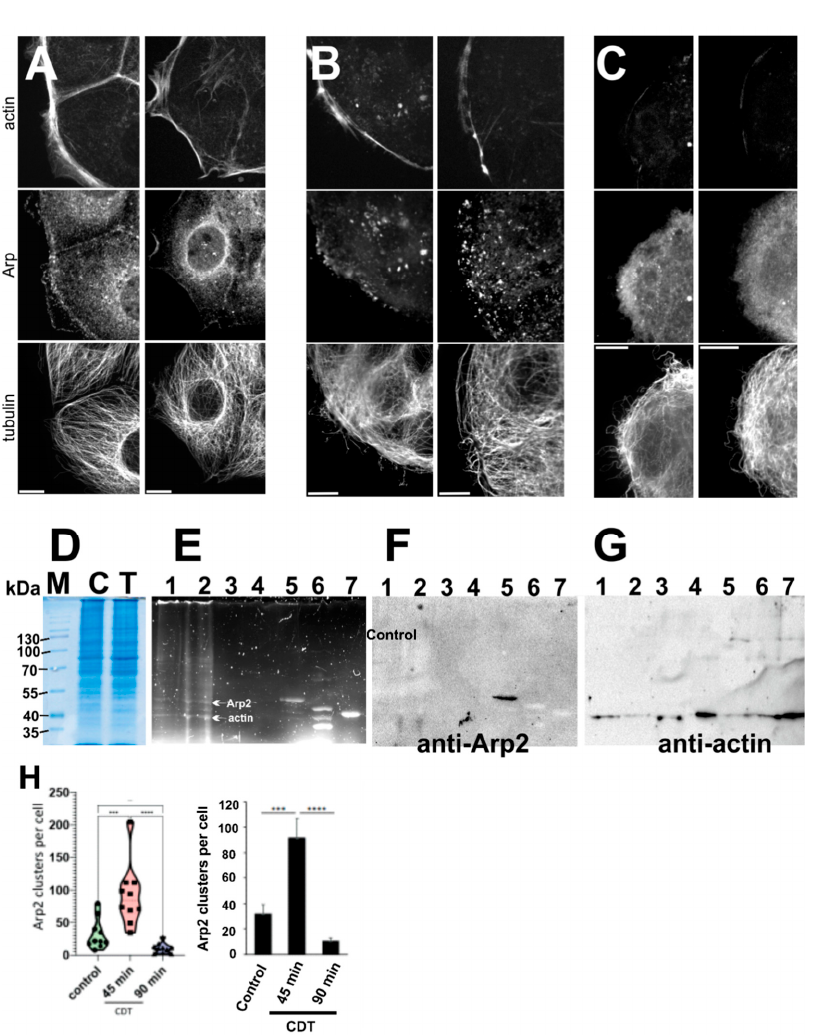
Figure 5. Effect of CDTa on Caco2 cells. ( A – C ) Caco2 cells seeded n coverslips were exposed to the CTDa and CDTb components to allow intracellular transport of CDTa by the membrane insertion CDTb component. ( A ) Control before intoxication, ( B ) 45 min and ( C ) 90 min after intoxication. After the indicated incubation periods, the cells were fixed and stained with TRITC-phalloidin (top rows). Anti-Arp2 mAb (middle rows); and anti-tubulin (lower rows) (for details see text). Bars correspond 10 µm. ( D – G ) Caco2 cells were incubated with CDTa and CDTb components, 0.1 mM etheno-NAD and 0.15 mM TritonX-100 to allow etheno-NAD diffusion into the cells. After 2 h or 3 h the cells were collected, washed 5 times in PBS and finally taken up in RIPA buffer to solubilize the cell content. After centrifugation the supernatants of the cell homogenates were analyzed by SDS-PAGE (12.5% polyacrylamide): ( D ) Coomassie blue staining of the control ( C ) and treated (T) cells. ( E ) Gives SDS-PAGE of cell homogenates and of the anti-Arp2 immune-precipitation (IP); the protein bands were fluorescently stained by inclusion of 0.5% trichloroethanol into the gel and visualized by the “oriol” setting of the BioRad transilluminator. ( F ) Gives the immunoblot of gel shown in ( E ) with anti-Arp2 mAB; and ( G ) with anti actin. Lanes in ( E – G ): Lane 1: homogenates of control and lane 2 of CDTa treated cells. Lanes 3 and 4: washing steps before final IP; lane 5: final anti-Arp2 IP showing Protein-A beads bound fluorescent material; lane 6: etheno-NAD labelled Acanthamoeba Arp2/3 complex; and lane 7: etheno-NAD labeled actin. Note lower molecular mass of Arp2 of Acanthamoeba Arp2/3 complex (upper band of lane 6). ( H ) Statistical evaluation of Z-stacks of cells treated and stained as in ( A – C ) were 3D-reconstructed (z-Step: 0.4 µ m) with Metamorph and the number of Arp2 accumulations with 0.07 to 1.7 µ m 3 was quantified per cell (ordinate) for the control and the cells treated with the CDTa and CDTb toxins (CDT) for 45 and 90 min. Differences were statistically analyzed by 1-way ANOVA with Tukey post-test. 10 fields of view were analyzed for each condition with ≥ 34 cells in total, from 2 independent experiments. The data are represented both in the “violin” mode and as columns. Asterisks indicate significant differences ( p ≤ 0.001:***; p ≤ 0.0001: